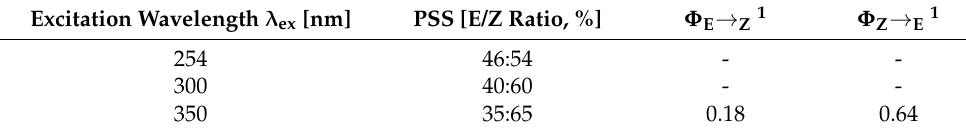
Table 1. Excitation wavelength, PSS, forward–backward photoisomerization quantum yields Φ .